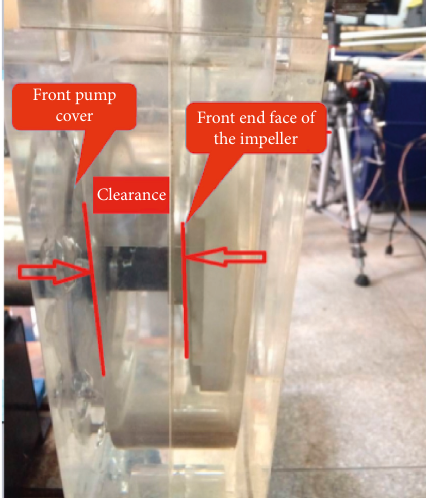
Figure 21: Schematic diagram of the impeller clearance of the lining plastic pump.